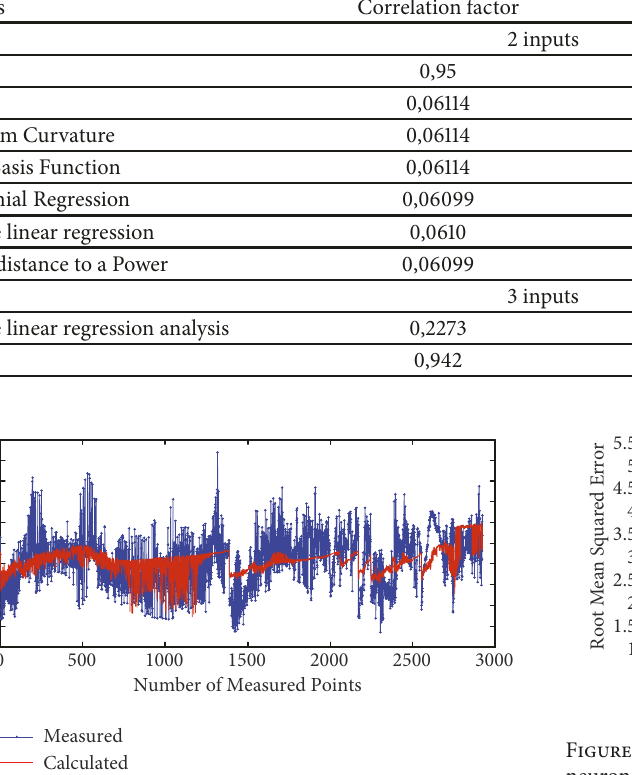
Figure 11: MLRA3 (red color) versus Bouguer anomalies measured (blue color).